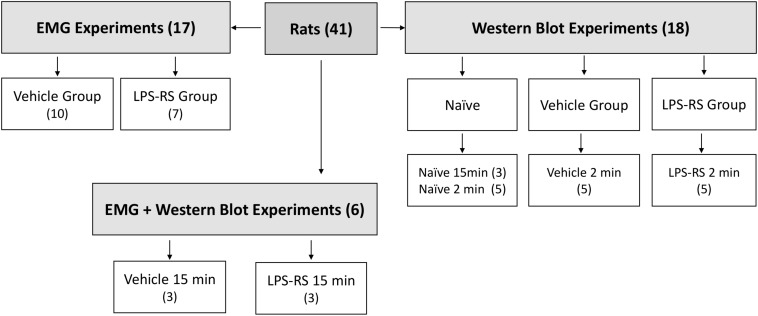
Schematic showing distribution of rats according to experimental groups. Note that some rats were solely used for the EMG experiments, some solely for the Western Blotting experiments, and some for both types of experiments. The EMG experiments included LPS-RS and vehicle groups of animals in which MO was applied to the tooth pulp after i.t. application of LPS-RS or vehicle, and the Western Blotting experiments involved LPS-RS and vehicle groups of animals euthanized at 2 and 15 min after MO application to the tooth pulp, as well as naïve animals.